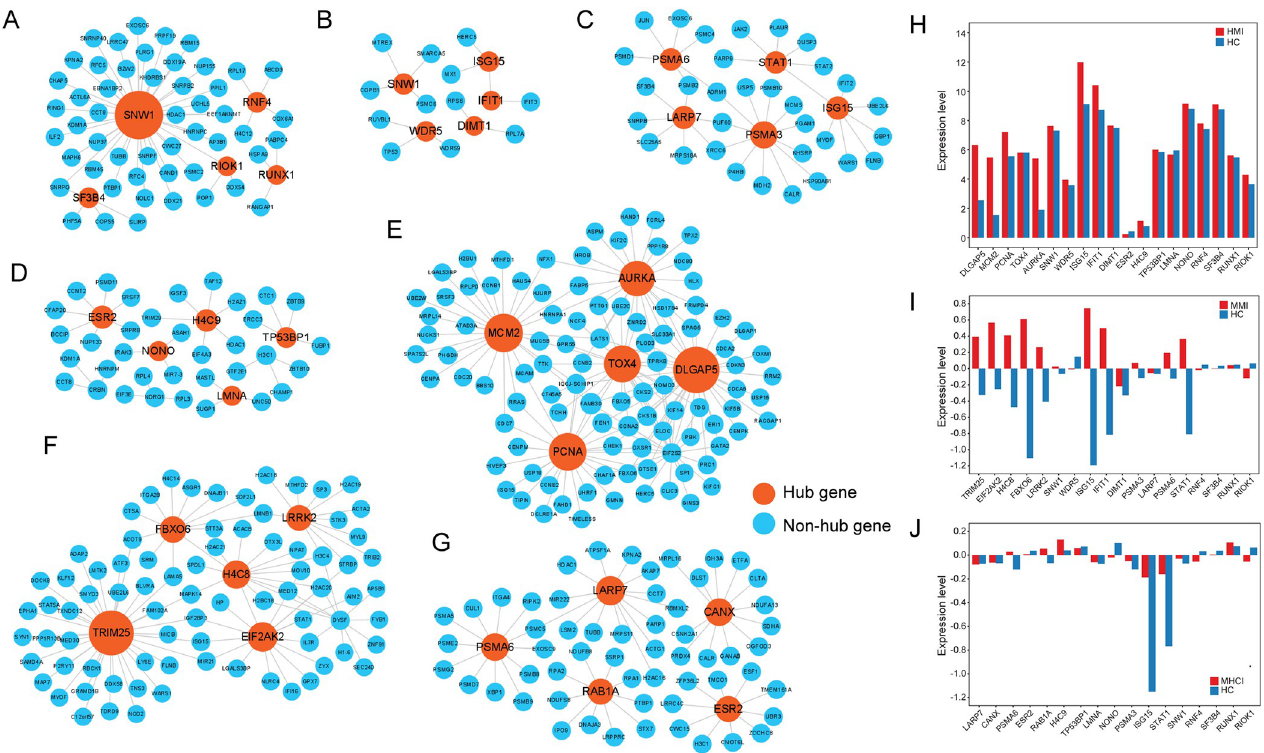
Fig 9. Analysis of hub genes in different subnetworks. (A) Hub genes in Common-P. (B) Hub genes in HMI-MMI-SP. (C) Hub genes in MMI-MHCI-SP. (D) Hub genes in HMI-MHCI-SP. (E) Hub genes in HMI-SP. (F) Hub genes in MMI-SP. (G) Hub genes in MHCI-SP. (H-J) Expression levels of hub genes in the disease and healthy